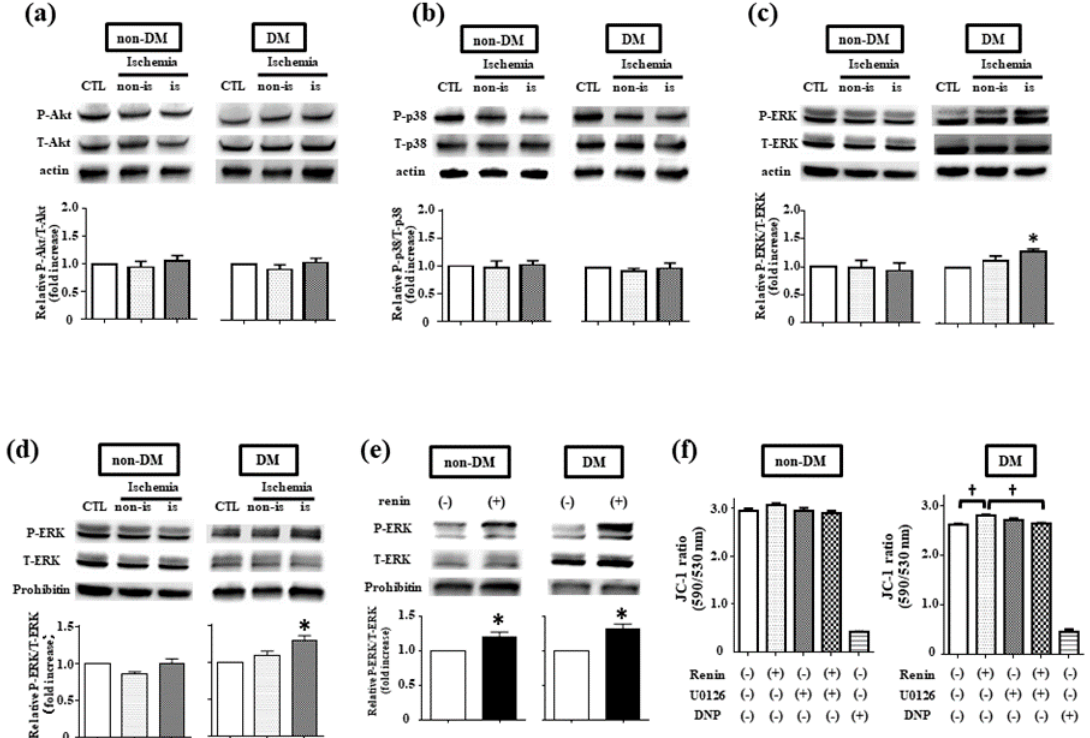
Figure 2. Pro-survival signals activation by rat recombinant renin (r-renin) and ischemia. Western blot analysis of intracellular signaling molecules, including Akt ( a ), p38 ( b ), and extracellular signal-regulated kinase 1/2 (ERK1/2): ( c ) in both non-DM and DM hearts. Hearts were subjected to ischemia for 70 min, and phosphorylation levels of intracellular signaling molecules (P-Akt, P-p38, and P-ERK) were assessed among the control, non-ischemic area (non-is), and ischemic area (is). Data represent the fold-increase of relative intensities in phosphorylated/total intracellular signaling molecules (T-Akt, T-p38, and T-ERK), and values are the means ± SEM from four independent experiments. * p < 0.05 vs. non-treated control (one-way ANOVA); ( d ) Representative Western blot analysis of total mitochondrial ERK1/2 and phosphorylated mitochondrial ERK1/2 both in non-DM and DM hearts. Hearts were subjected to ischemia for 70 min, and then mitochondria were isolated as described in the Materials and Methods. The phosphorylation levels of mitochondrial ERK1/2 were assessed in the non-ischemic area (non-is) and ischemic area (is). Non-ischemic heart was used as a control (CTL). Data are presented as fold-increase of phosphorylated/total mitochondrial ERK1/2 from CTL, and values are the means ± SEM from seven isolated experiments; ( e ) Western blot analysis of mitochondrial ERK1/2 phosphorylation. Isolated mitochondria from non-DM and DM hearts were exposed to rat recombinant renin (r-renin, 100 ng/mL) for 30 min, and phosphorylation levels of ERK1/2 were evaluated. Bars indicate relative intensities of phosphorylated/total ERK1/2, and values are the means ± SEM from five experiments. * p < 0.05 vs. control (one-way ANOVA); ( f ) Summarized data of 5, 5 ′ , 6, 6 ′ -tetrachloro-1, 1 ′ , 3, 3 ′ -tetraethylbenzimidazol-carbocyanine iodide (JC-1) in isolated mitochondria from non-DM and DM hearts. Isolated mitochondria were exposed to r-renin (100 ng/mL) for 30 min in the presence or absence of U0126 (1 µM). As a reference, an uncoupler of DNP (100 µmol/L) was applied to mitochondria both from DM and non-DM hearts. Values are the means ± SEM from three different experiments. * p < 0.05, † p < 0.01 vs. non-treated control (one-way ANOVA).